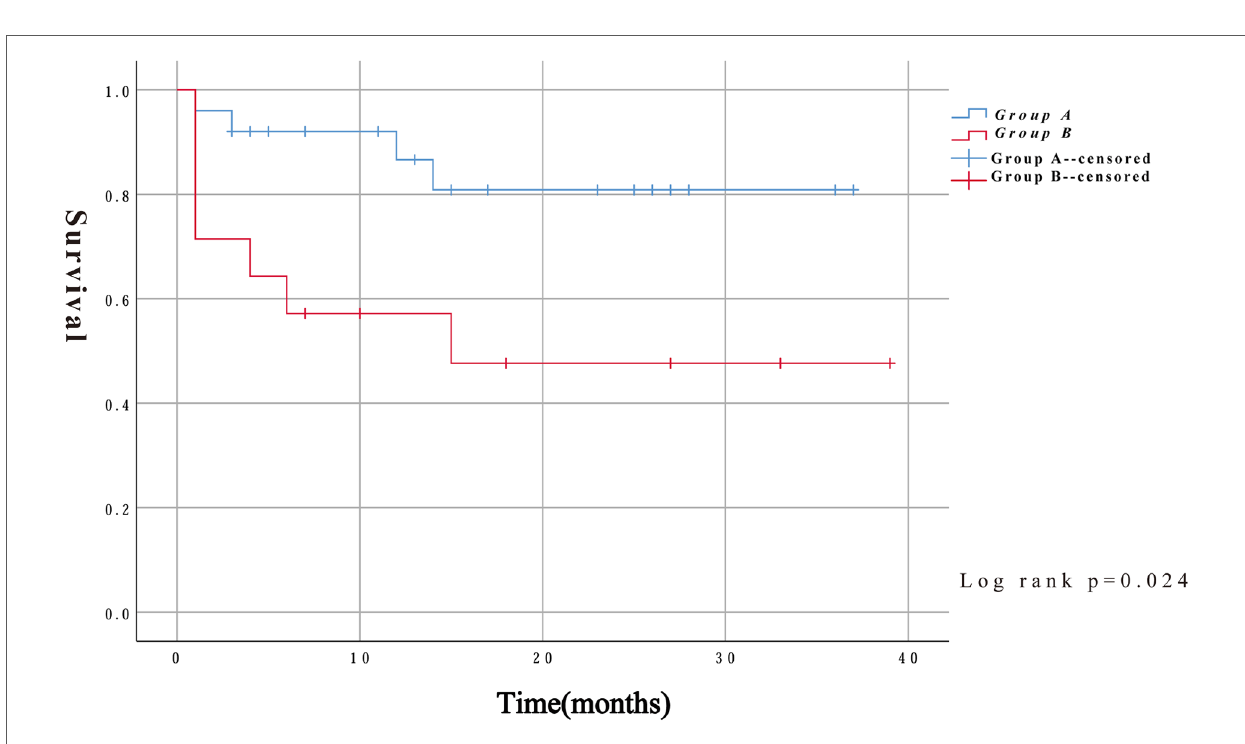
FIGURE 4 Kaplan Meier curves for midterm survival were compared among the two